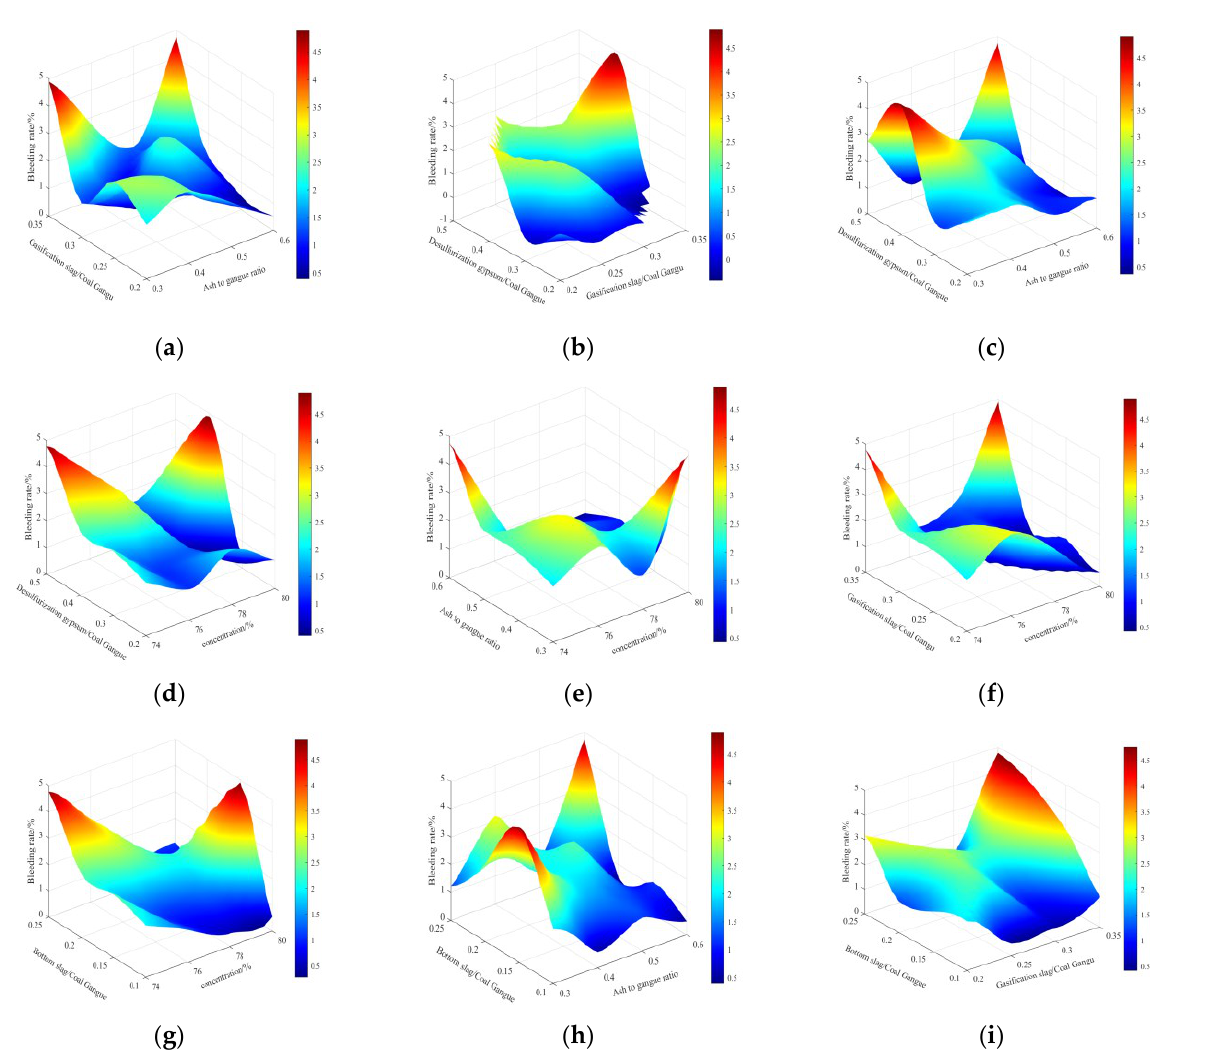
Figure 12. Effect of coal-based solid waste filling material on bleeding rate. ( a ) Factors of B and C; ( b ) factors of C and E; ( c ) factors of B and E; ( d ) factors of A and E; ( e ) factors of A and B; ( f ) factors of A and C; ( g ) factors of A and D; ( h ) factors of B and D; ( i ) factors of C and D.